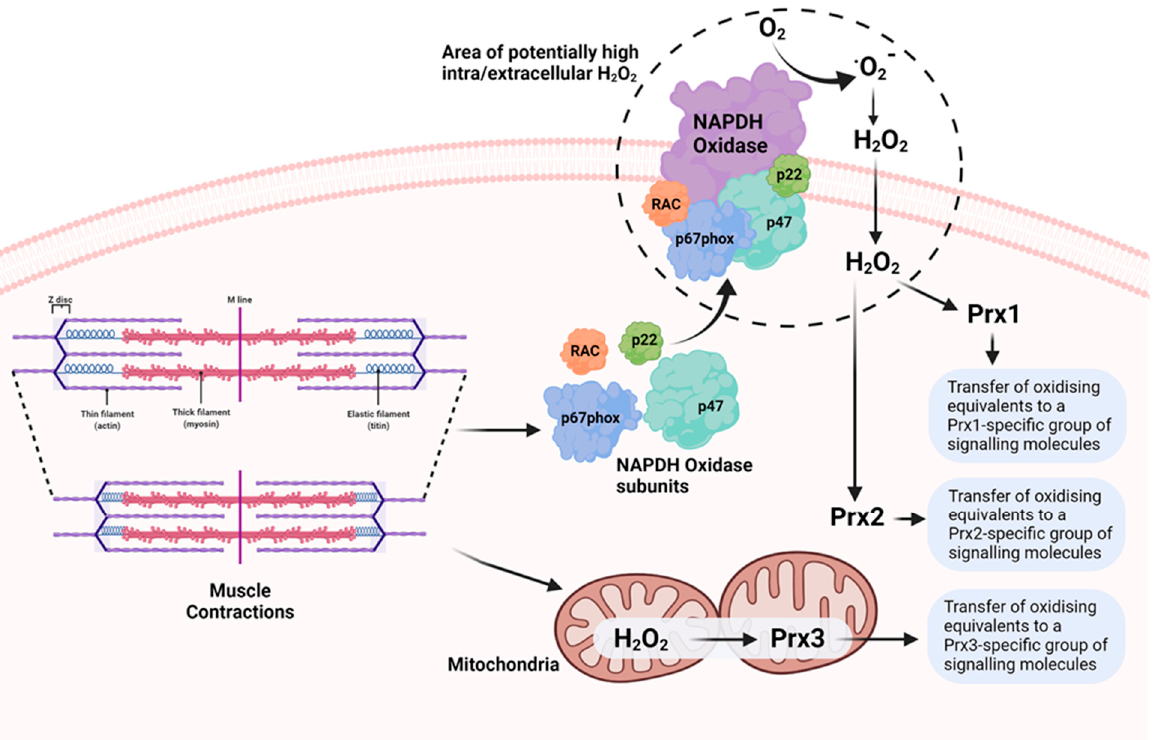
Figure 3. Potential mechanisms underlying generation of ROS (superoxide and H 2 O 2 ) during muscle contractions and oxidation of 2-Cys Prx in different cellular compartments, leading to activation of specific groups of Prx-interacting signalling molecules involved in muscle adaptations to the contractile activity.